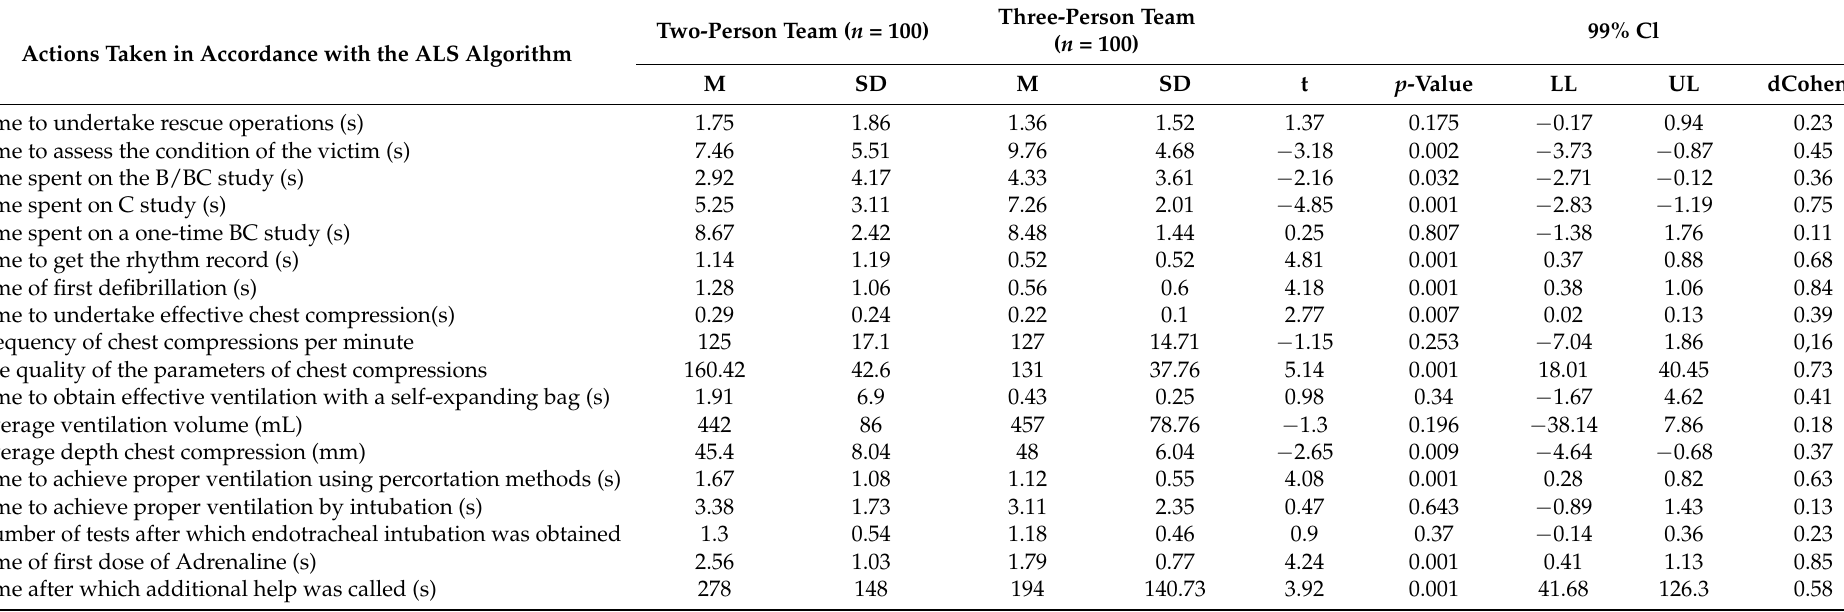
Table 1. Comparison of the duration of two- and three-person basic emergency medical teams during advanced resuscitation procedures in adults under simulated conditions.